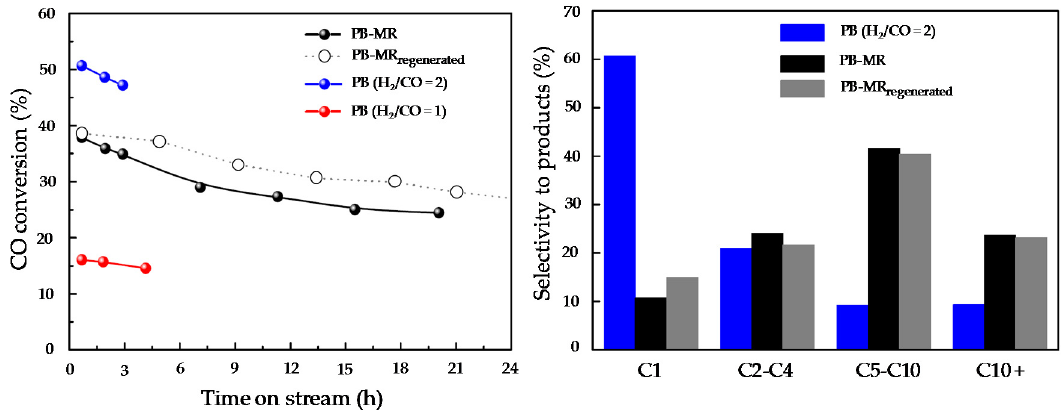
Figure 23. ( left ) CO conversion at 280 °C vs. time ‐ on ‐ stream for the following configurations: PB ‐ MR (H 2 /CO = 1) inside (black line), PBR H 2 /CO = 2 (blue line) and PBR H 2 /CO = 1 (red line) at P = 10 bar, GHSV = 7500 mL CO+H2 /g cat /h; Δ P H2 = 9 bar; ( right ) Product selectivity [24].